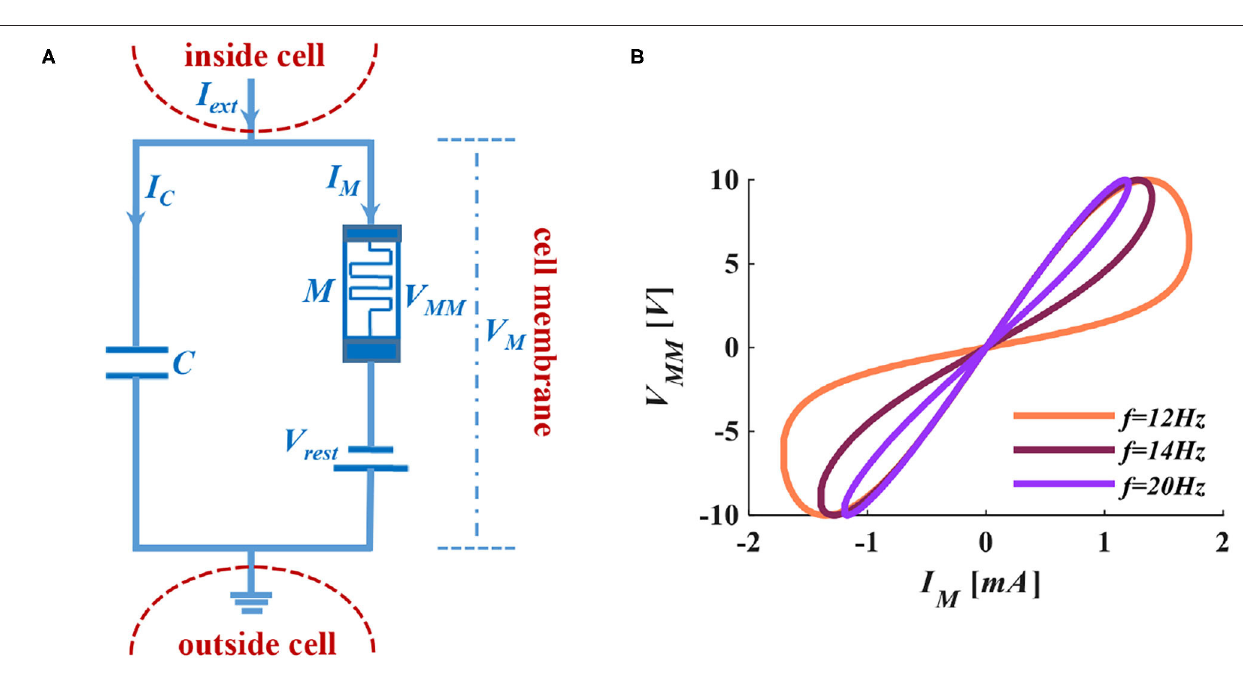
et al., 2013). In Figure 2B , the distribution of the curve is in the first and third quadrants, which indicates that the device is passive. The curve has two prominent switching states and